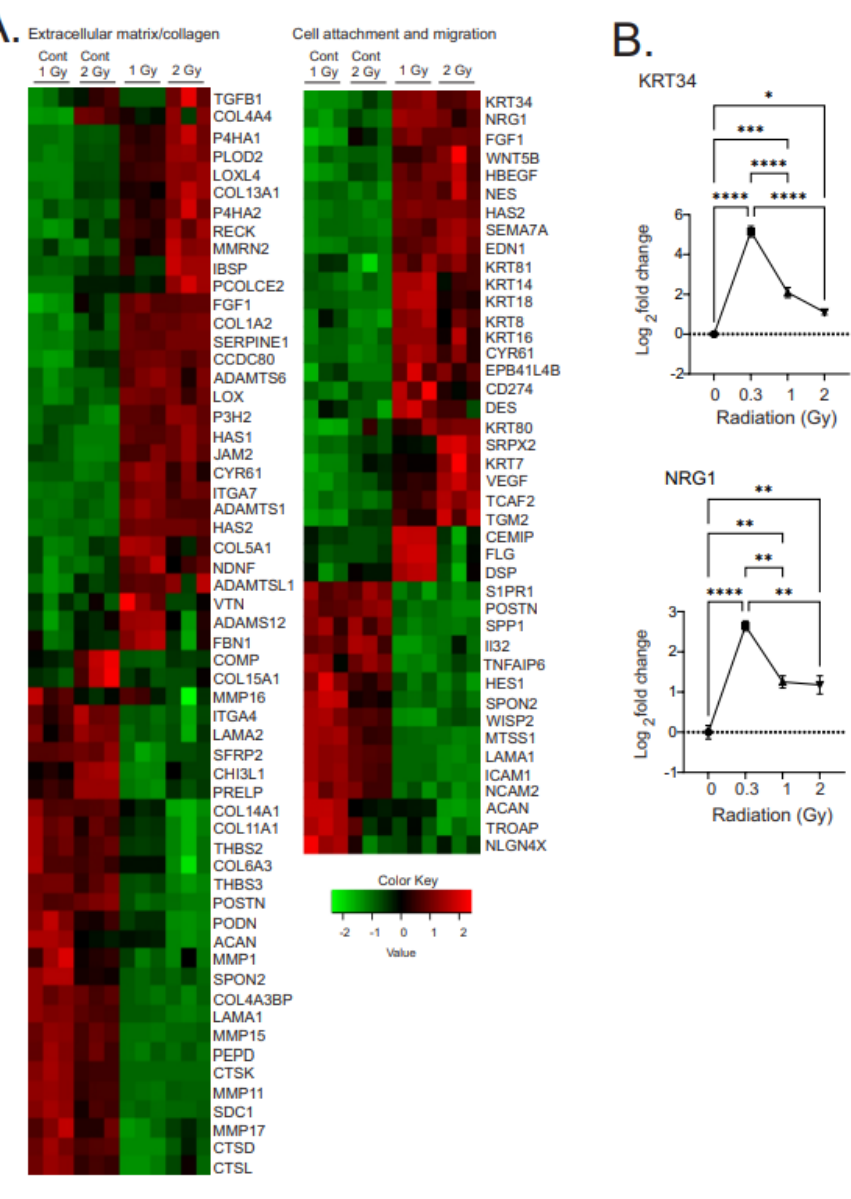
Figure 7. Heatmaps of gene expression changes for pathways involved in the regulation of extracel- lular matrix and collagen synthesis and cell attachment and migration. ( A ). RNAseq was used to identify gene expression changes in primary human MSCs following 1 or 2 Gy (0.66 cGy/h) 60 Co irradiation. Control cells were cultured under identical conditions for 1 or 2 weeks. GO analysis was performed using DAVID and heatmaps were generated using genes with q < 0.05. Rows are centered and unit variance is applied to rows. ( B ). qPCR gene regulation using log base 2 scale fold change of genes supporting heatmaps of pathways. Data show averages ± SEM from N = 3 biological replicates with two technical repeats. * indicates p < 0.05, ** indicates p < 0.01, *** indicates p < 0.001, **** indicates p < 0.0001, respectively, compared with sham-irradiated control cells.